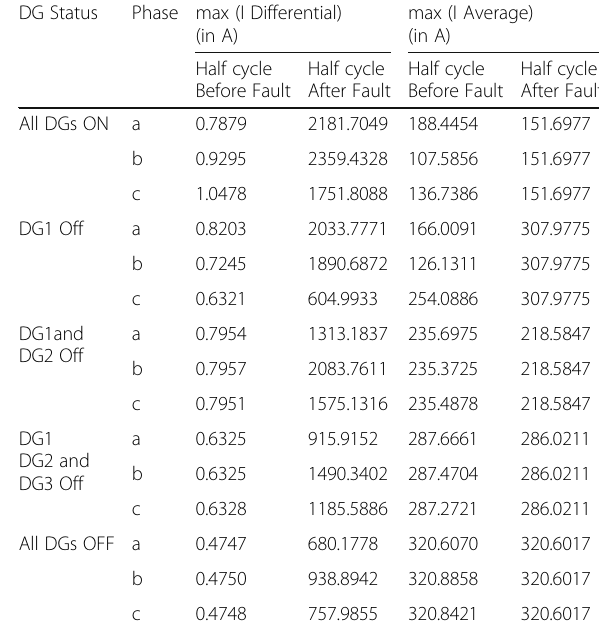
Table 1 Effect of variation of penetration level of the DG ’ s on the magnitude of fault current (differential and average) at distribution Line DL AB for a single line to ground fault (a-g) fault on at fault distance ratio ( FDR ) = 0.4 and fault resistance ( R f ) = 5 Ω , respectively, where the microgrid is operated in grid connected mode